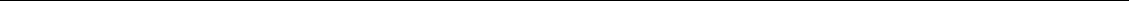
Fig. 2 The fi ring rate of individual neurons correlates with task-performance of the animal during multiple rule changes. a Individual spikes (black ticks) are plotted around the time of reward activation (0 s). The corresponding behavioural performance is plotted at the right of the raster plot and colour coded according to rules. Note that spike activity is modulated by the performance. The correlation value (r) between trial-by-trial fi ring rate and performance is indicated (Spearman correlation). Grey lines denote rule changes. b The fi ring rate of two neurons (Neuron HM06-0425T10C6 and Neuron HM02- 0419T9C4) are negatively or positively correlated to performance during the task irrespective of the trial time segment. c Histograms of correlation values ( fi ring rate versus task-performance) for 300 recorded neurons and for different trial segments. n represents number of neurons with fi ring rates signi fi cantly correlated to task performance (Spearman ´ s correlation, p < 0.05 after Bonferroni – Holm correction). d Cumulative distribution functions of individual neurons ‘ correlation values for different trial segments. e Comparison of observed and shuf fl ed cumulative distribution functions of individual neurons ’ correlation values for different trial segments. Dotted lines indicate con fi dent intervals at 2.5 and 97.5 %. Note that the fi ring rates of